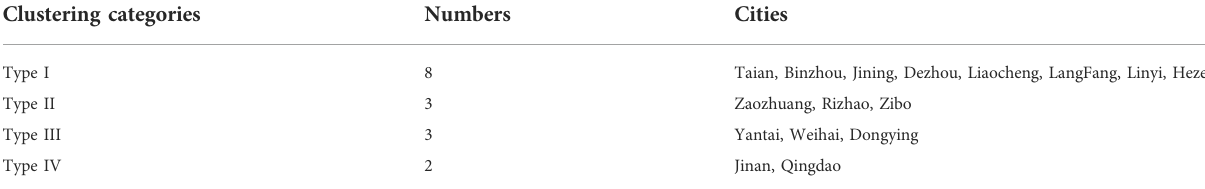
TABLE 4 Cluster analysis